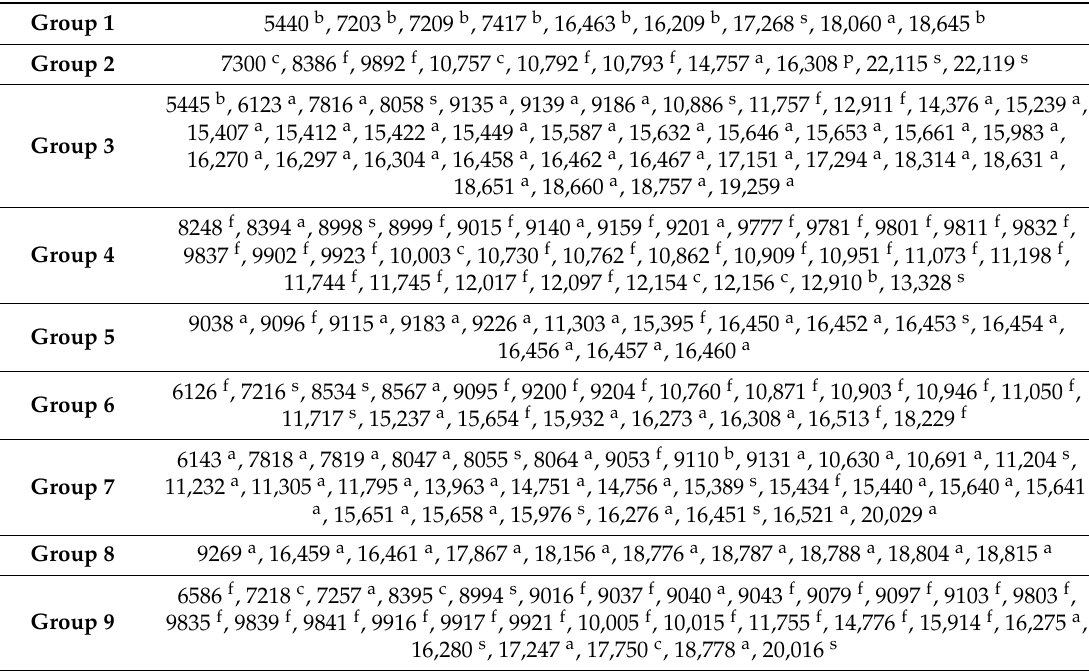
Table 4. Description of the 9 groups of accessions from Figure 1, including species